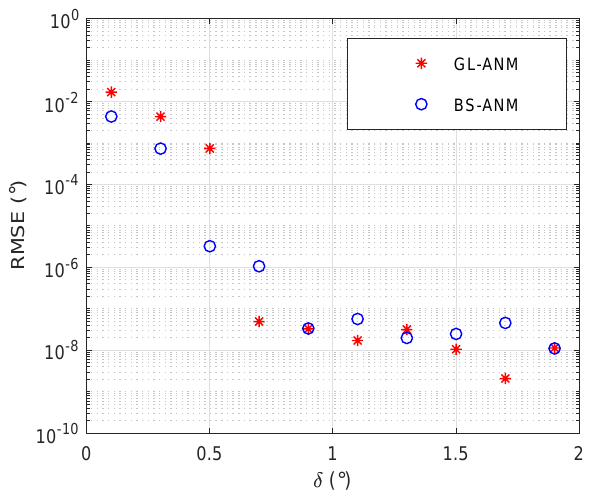
Figure 2. RMSE versus angle separation δ for the GL-ANM and BS-ANM